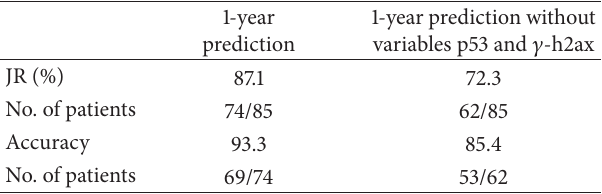
Table 5: Comparison of predictive models for 1-year prediction.